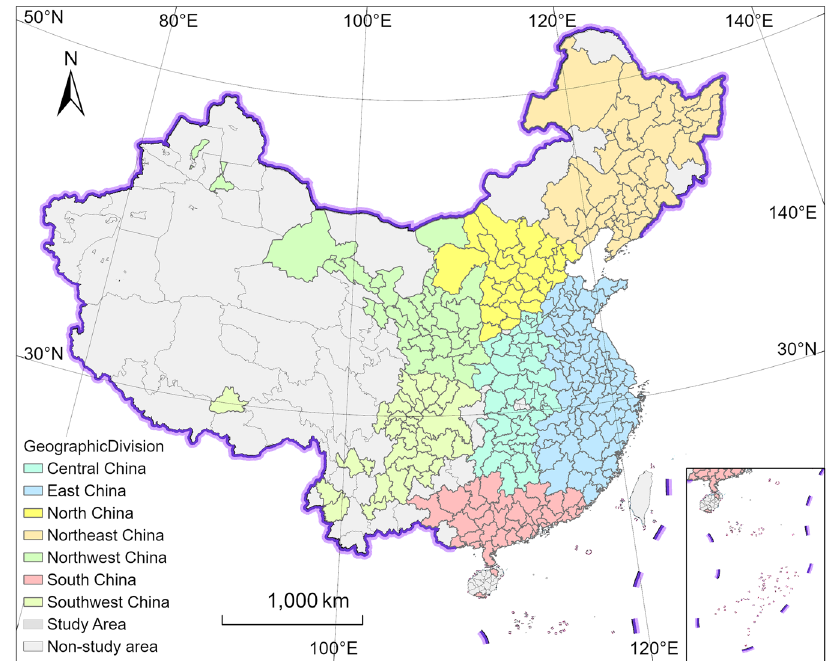
Fig. 1 Spatial distribution and geographic division of cities in the study area. The 286 cities are divided according to China ’ s seven natural geographical divisions, as depicted in the fi gure. The divisions usually combine several geographically and culturally close provinces into one area. The map was developed by the authors using ArcGIS Pro Version 3.0.2, and the background map was issued by the Ministry of Natural Resources of the People ’ s Republic of China (drawing review No. GS (2020) 4619), as shown in the website: http://bzdt.ch.mnr.gov.cn/. Table 1 Index system for the pseudo-human